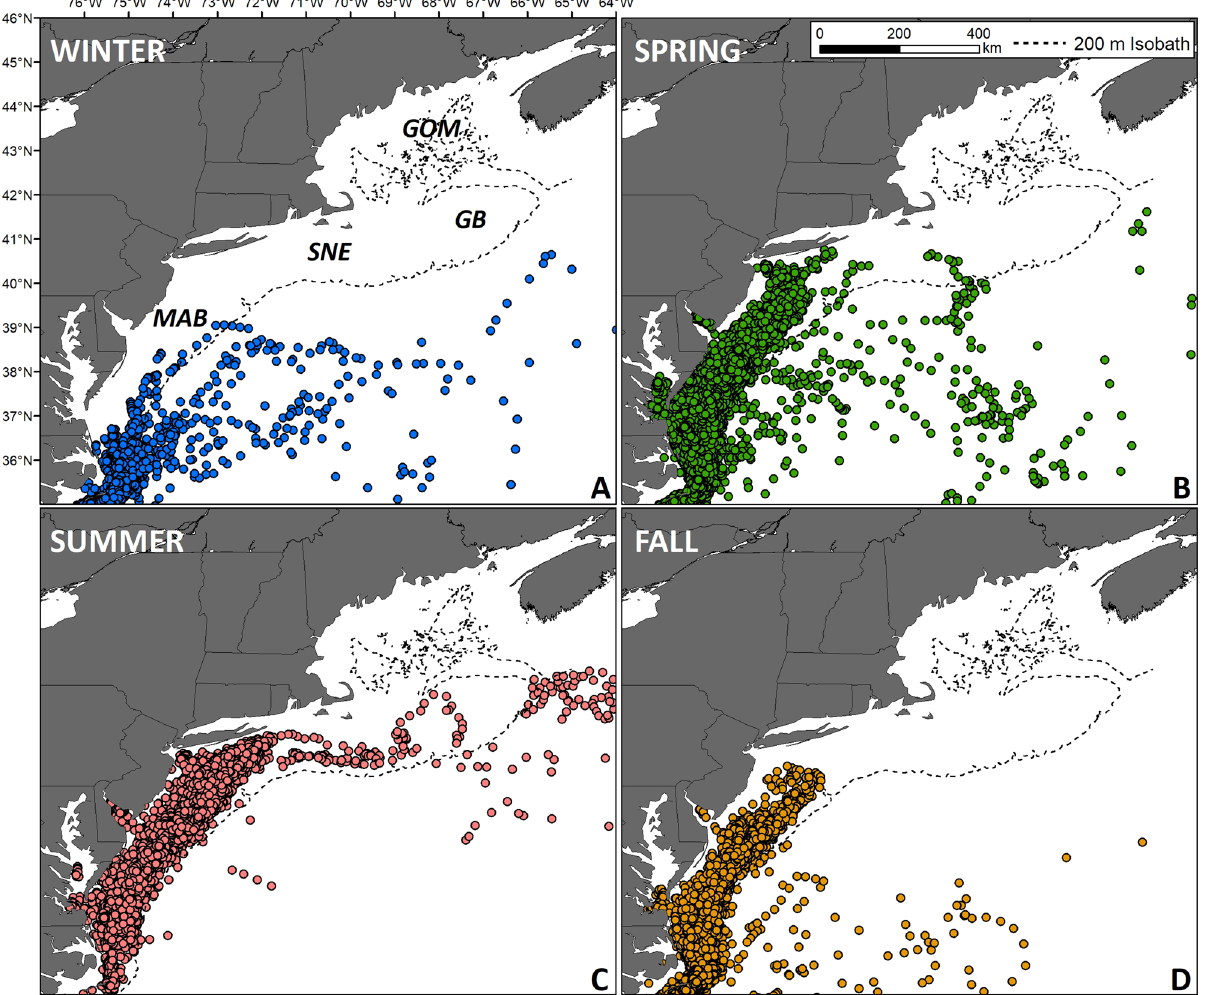
Figure 1. Reconstructed tracks from 196 loggerhead sea turtles satellite tagged between 2009 and 2018 within the northwest Atlantic. Dashed lines denote the 200 m bathymetric contour. GOM = Gulf of Maine, GB = Georges Bank, SNE = Southern New England, and MAB = Middle Atlantic Bight. Maps prepared with ArcMap 10.8, www. esri.